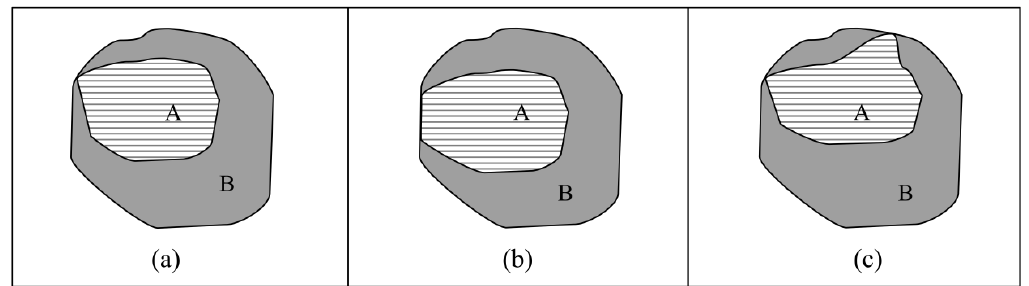
Figure 2. ( a – c ) Spatial objects and their topological relations.